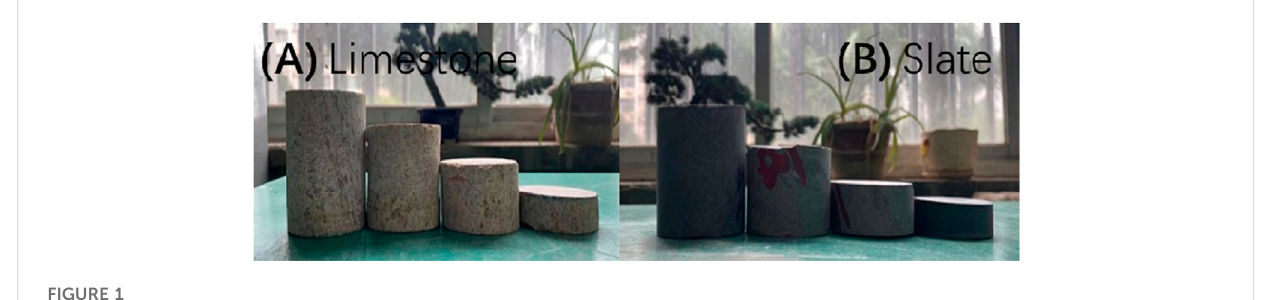
FIGURE 1 Partial group of rock